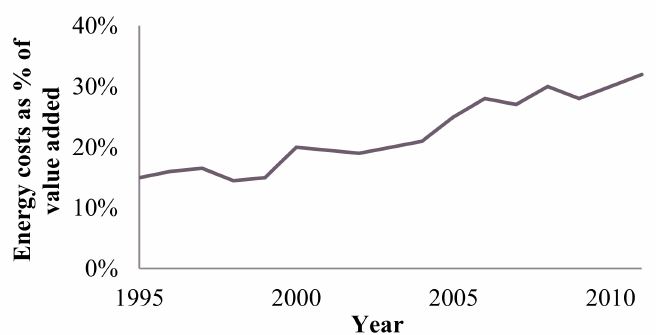
Figure 1. Energy costs as a percentage of the value added in the manufacturing sector for the EU27.